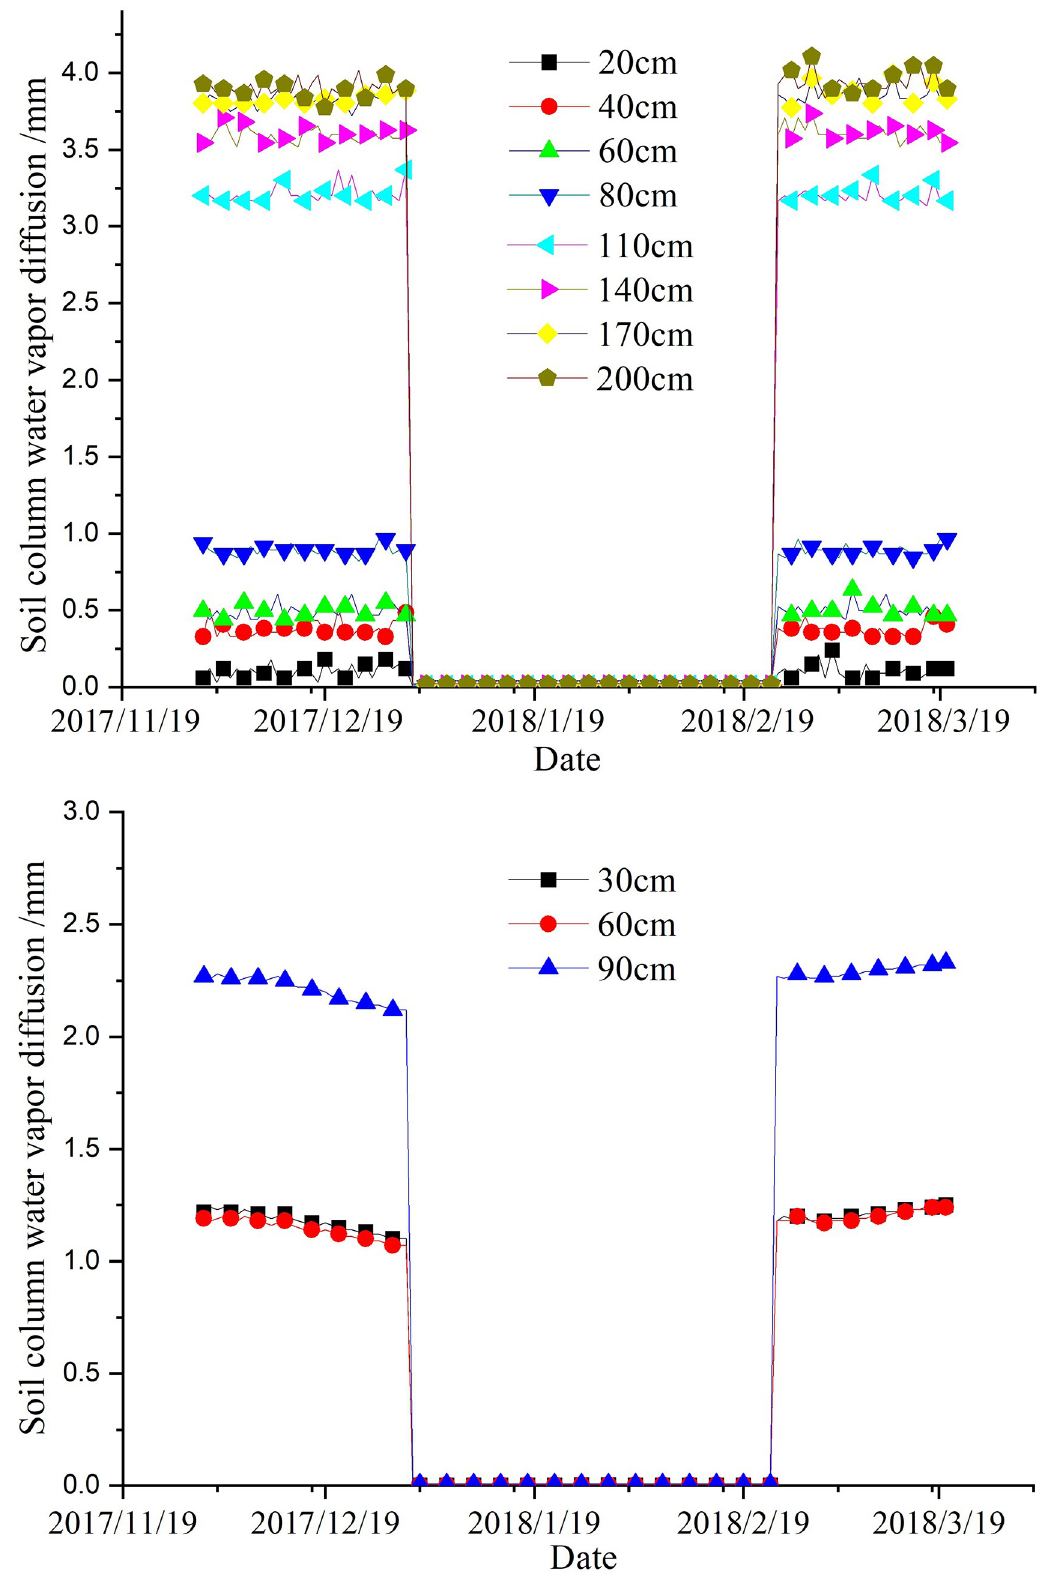
Fig 15. A qualitative analysis of vertical frozen soil pillar water vapor diffusion (Zhang Chaoyi et al. 2018). (a) clay. (b) Sandy loam soil. https://doi.org/10.1371/journal.pone.0258861.g015 PLOS ONE | https://doi.org/10.1371/journal.pone.0258861 November22,